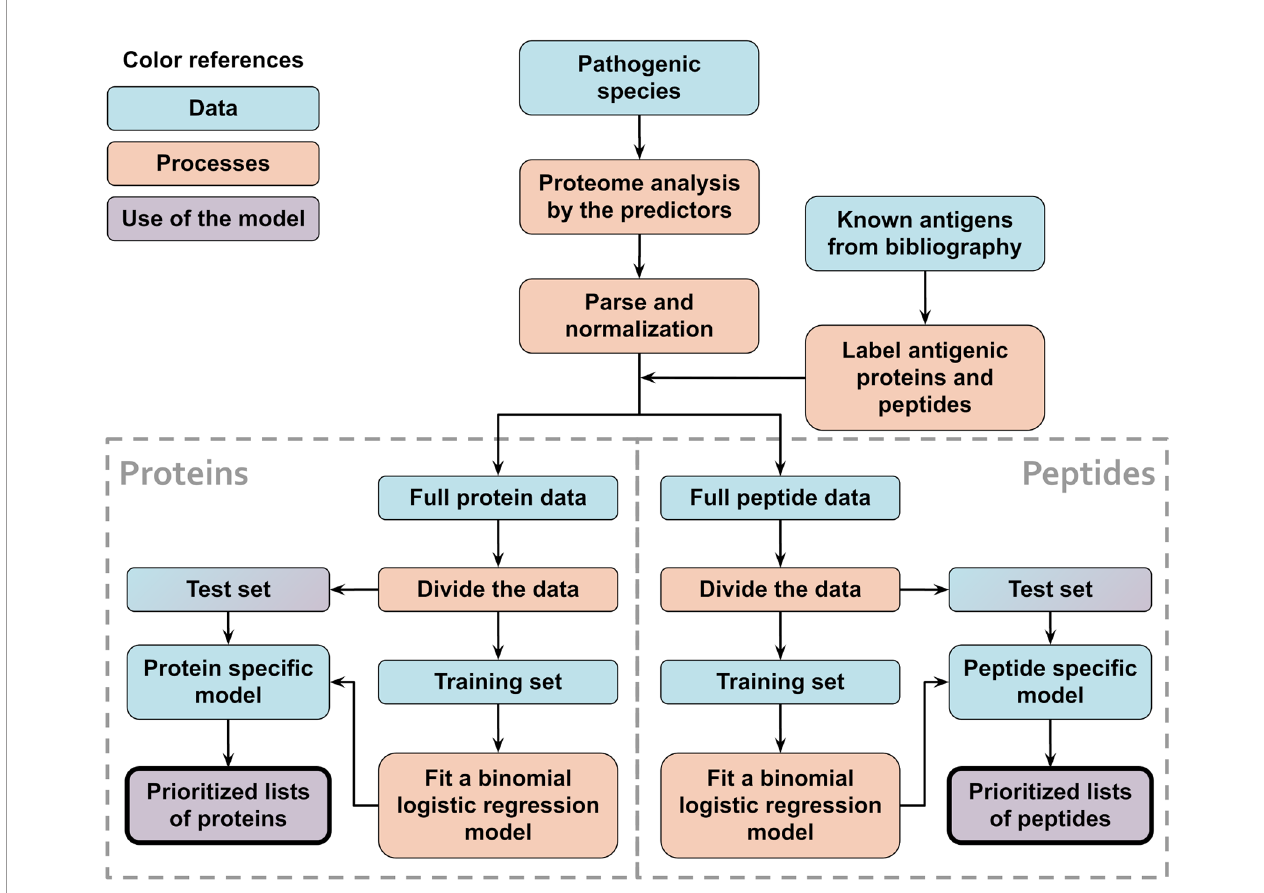
FIGURE 1 | Schematic fl owchart used to obtain APRANK ’ s species-speci fi c models. With the aim of testing and tuning our method, training and prioritization was performed for both proteins and peptides using data from a single proteome of interest. This process was repeated for all of our 15